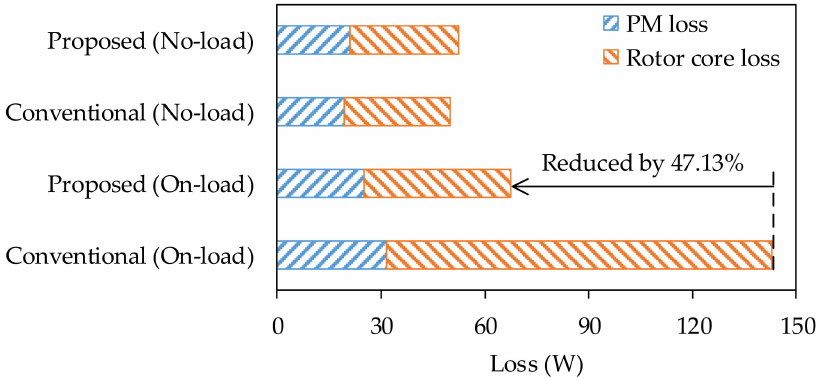
Figure 16. Rotor losses of the two compared